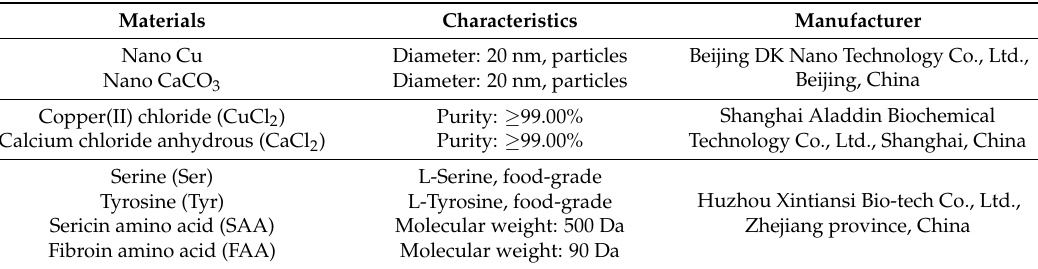
Table 1. Characteristics of eight different